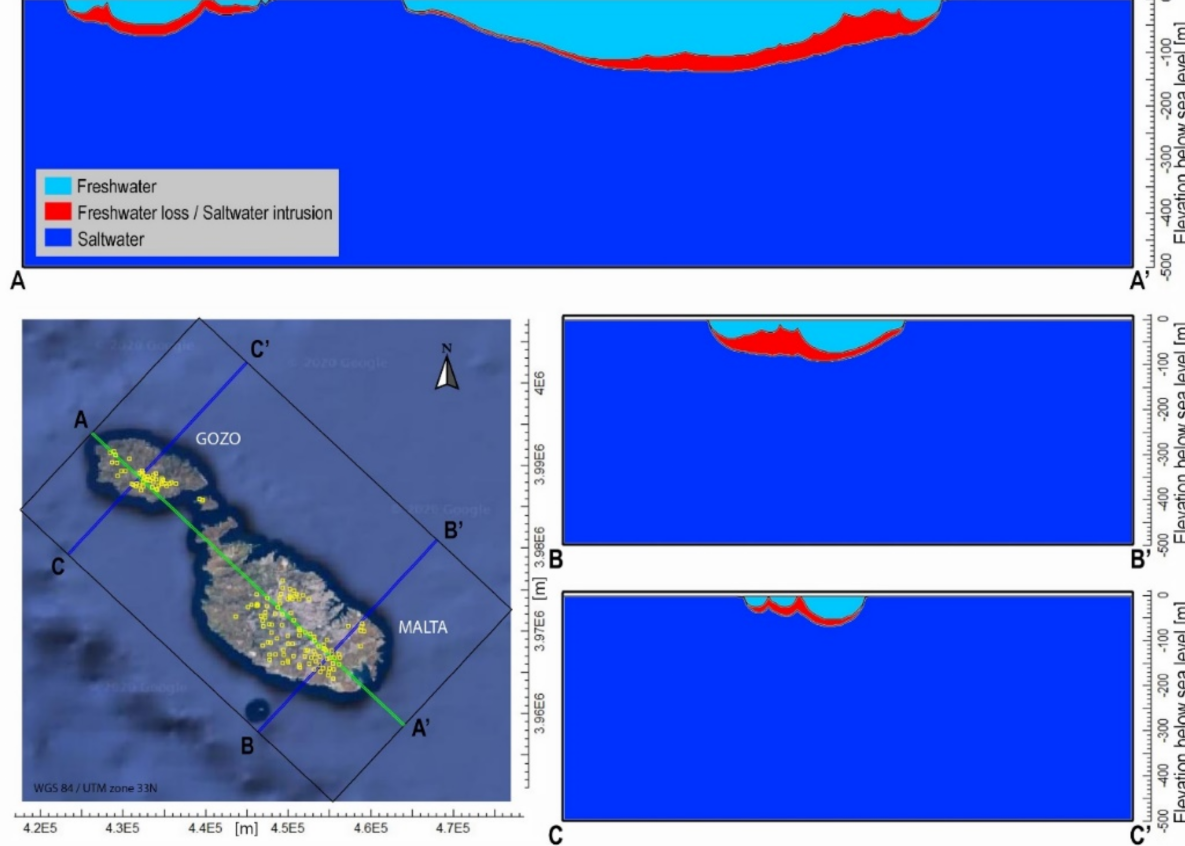
Figure 8. Vertical cross sections showing the extent of saltwater intrusion in 2100 between the reference condition and the worst scenario caused by the climate change effects (30% decrease in groundwater recharge, 74% increase in water demand and a sea-level rise of 0.5